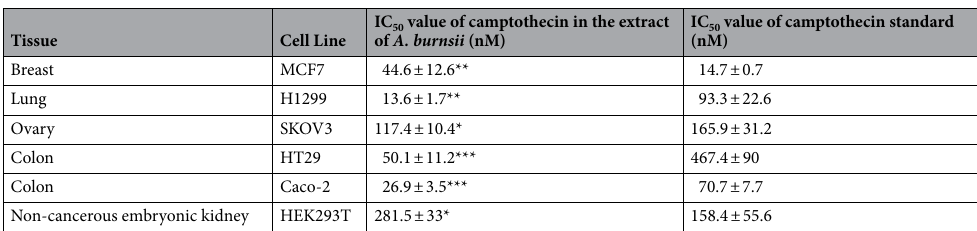
Table 3. Cytotoxic activity of crude extract of camptothecin from A. burnsii and camptothecin standard on the various cancerous and non-cancerous cell line. Confidence interval for statistically different IC 50 of the camptothecin extract, in comparison to that of the standard, for each cancerous cell line: *p ≤ 0.05; **p ≤ 0.01; ***p ≤ 0.001.